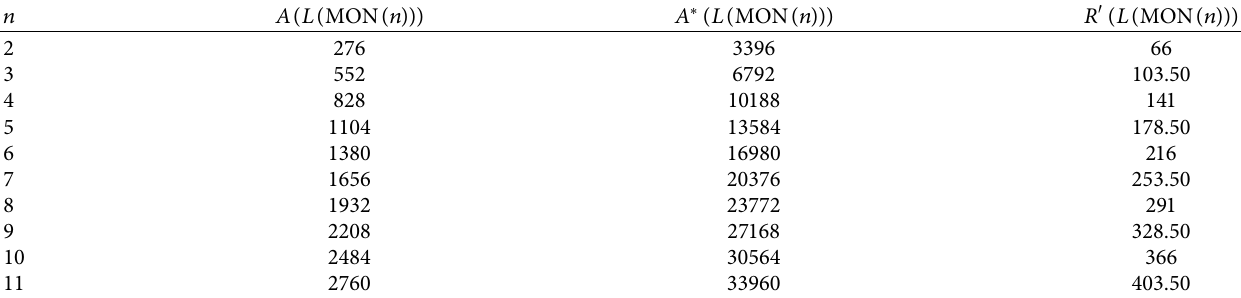
Table 3: Comparison of the Albertson, modified Albertson, and variation of Randi´c indexes.